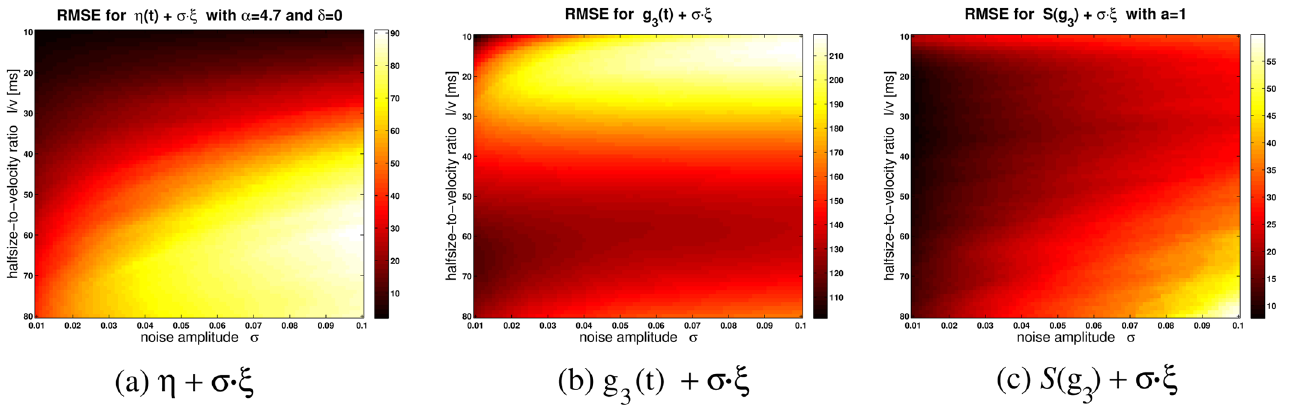
Fig 2. How noise interacts with maximum detection. This figure shows how the numerical detection of the global maximum ^ t max is affected by adding noise to the η -function, g 3 ( t ), and S ( g 3 ). To this end, the root mean square error (RMSE) between ^ t max and the theoretical (i.e. noise-free) t max is determined across 999 trials. The RMSE is computed as a function of noise amplitude σ (abscissae) and the halfsize-to-velocity ratio l / v (ordinates). Brighter ( “ hotter ” ) colors denote bigger RMSE values (see colorbar; units in milliseconds). Noise is added as follows. Let ξ be a normal-distributed random variable with mean zero and standard deviation one. Then, ( a ) η ( t ) + σξ is the “ noisi fi ed ” η -function (with δ = 0 and α = 4.7), ( b )shows the RMSE for g 3 ( t ) + σξ , and ( c ) S ( g 3 ) + σξ (with a = 1 in Eq (8)). The curves of η ( t ), g p ( t ) and S ( g p ) become fl atter for higher halfsize-to-velocity ratios (cf. Fig 1). In addition, the curves of g p ( t ) become fl atter for decreasing values of a and p , respectively. Flatter curves are associated with an increased fl atter for increasing p , and the curves of S ( g p ) get RMSE. Although g 3 ( t ) + σξ is associated with higher RMSE values than η ( t ) + σξ , the completely “ decoded ” function S ( g 3 ) has a better overall robustness against additive Gaussian noise than η ( t ). For each value of l / v , g 3 ( t ) and S ( g 3 ) were re-scaled before noise was added, in order to match the range of η ( t ), and thus normalize the RMSE. For all fi gure panels, t c = 0.5s and l =